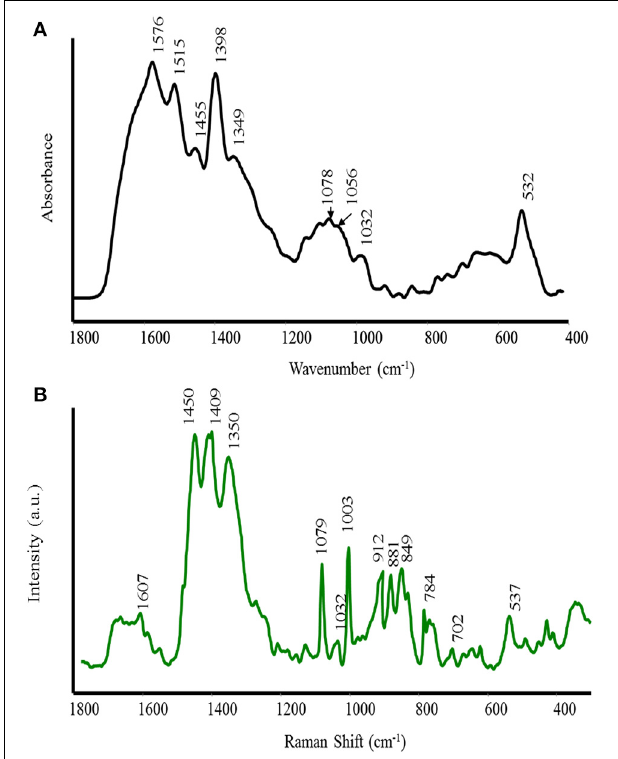
FIGURE 1 | FT-IR (A) and Raman (B) spectra of alfalfa hydrolyzed (AH) biostimulant.